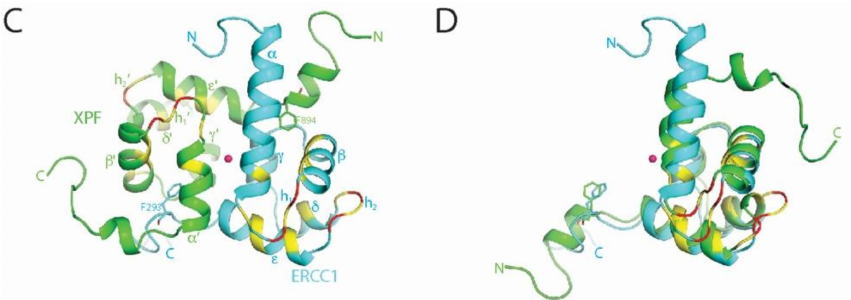
Figure 4. Schematic representation of human ERCC1-XPF. ERCC1 and XPF do not only interact with each other, but also with other proteins. A , shows the domain architecture, mutations and interactions. The expansion of key residues is represented above the active site (in yellow) within the XPF nuclease domain. Protein names in grey denote unconfirmed or undefined protein–protein interactions and confirmed interactions are written black. NLS is the abbreviation for nuclear localization sequence. Numbers denote residue number, arrows show mutations, asterisks are used to denote stop codons, and the horizontal bars identify the proteins. B , (HhH) 2 domains of A. pernix XPF and human ERCC1 and XPF are compared by structure-based alignment using the DaliLite server [157] with sequence alignment colored in boxshade [grey for similar and black for identical [158]]. The signature residues based on multiple sequence alignment of HhH motifs by Doherty et al. [159] are manually colored (yellow for hydrophobic and red for Glycine) and denoted below the sequence (G indicates conserved glycine residues; h indicates a hydrophobic side chain). The secondary structure elements are shown based on the structure of human ERCC1 (HhH) 2 domain. C , the NMR structure of heterodimeric complex of the human ERCC1-XFP (HhH) 2 domains with the two-fold pseudo-symmetry axis (central red dot). D , Overlay of ERCC1 and XPF (HhH) 2 structures using DaliLite [157], showing the overall fold similarity and close overlap of conserved F293 and F894 anchor residues. ERCC1 is depicted in blue, XPF in green, and the HhH motif signature resides are in yellow and red; GhG denotes signatures residues for hairpins. A and B and are adapted from [104] and [160],